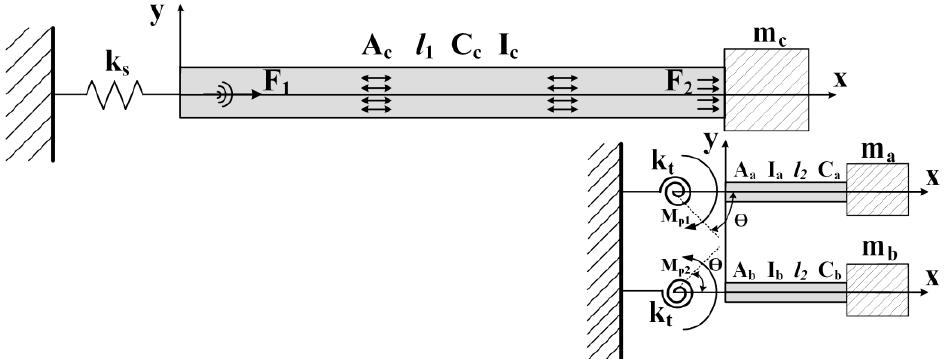
Figure 9. Simplified dynamic model of scissor-type micro-stirrer.